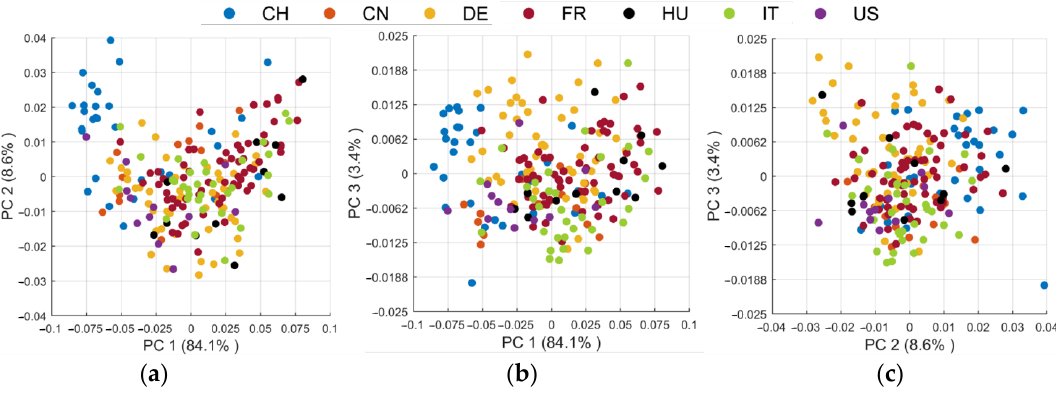
Figure 4. Principal component analysis (PCA) score plots of the 212 walnut samples after pre-processing combination H7 (see Table 5: ( a ) principal component (PC) 1 vs. PC 2; ( b ) PC 1 vs. PC 3; ( c ) PC 2 vs. PC 3.